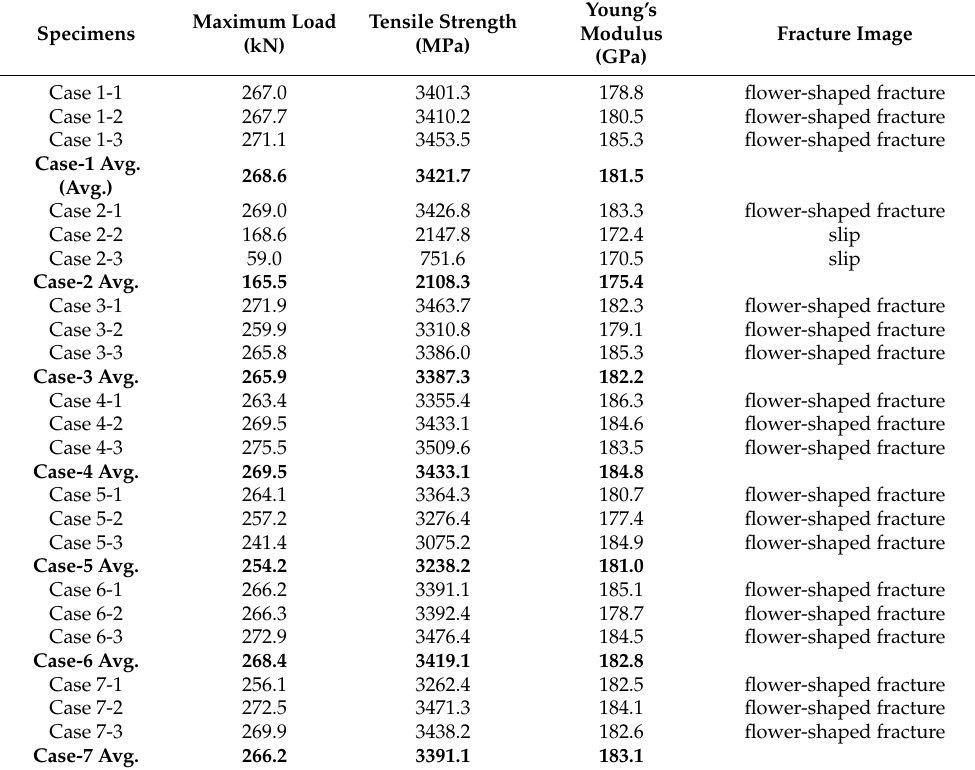
Table 4. Bond performance improvement outcomes pertaining to the tested